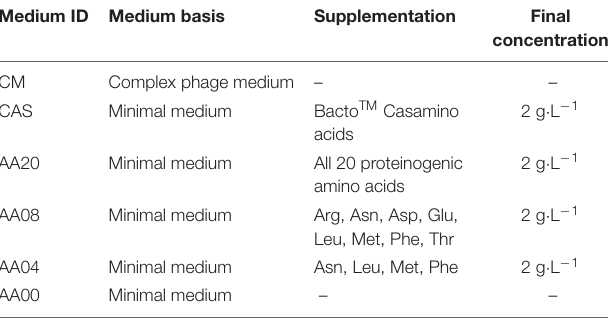
TABLE 1 | Media compositions and supplementation for both: chip- and MTP-based